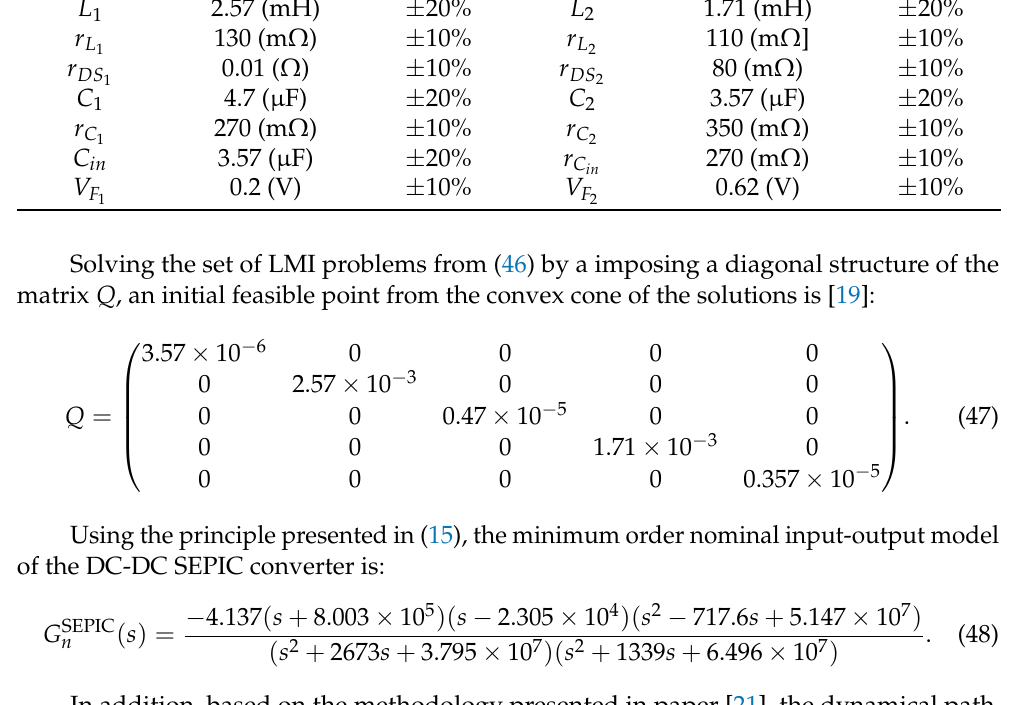
Table 1. Nominal circuit element values and tolerances for the SEPIC DC-DC converter. Parameter Nominal